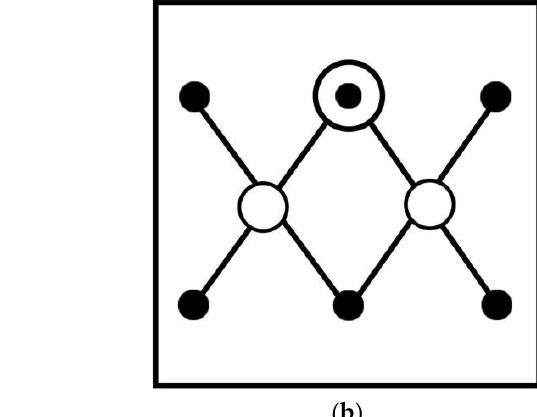
Figure 13. ( a ) Spatial pattern of the city network in the middle Ganga Plain. Source: the authors; Base Map: Google satellite map; Reference: [65]; ( b ) Pyramidal pattern dominated by a political sys- tem. Source: the authors.